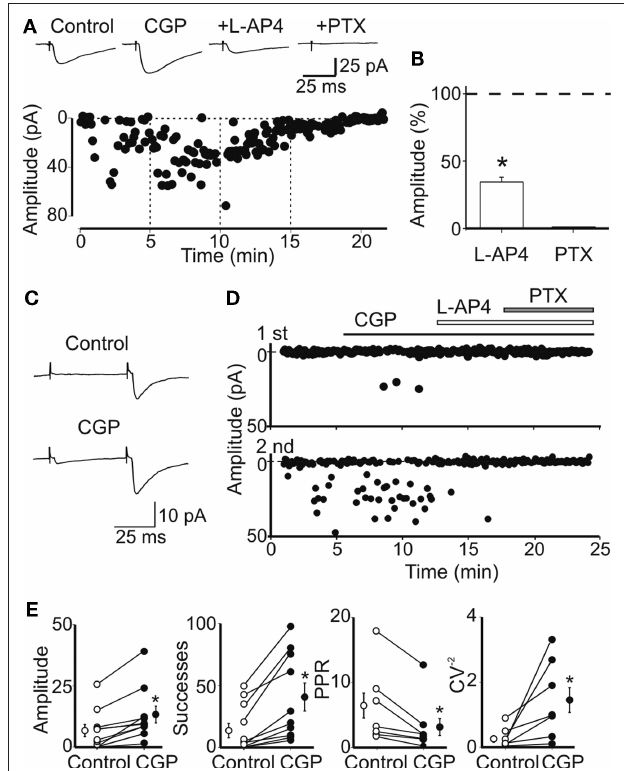
FIGURE 2 | Block of GABA receptors with CGP55845 enhances the B probability of GABA release from mossy fi ber terminals. (A) Peak amplitude of MF-evoked synaptic currents in control, during bath application of CGP55845 (1 μ M), CGP plus L-AP4 (10 μ M) and CGP plus L-AP4 and picrotoxin (100 μ M, vertical dashed lines). Note the reduction in the number of failures in CGP. Current responses were reduced in amplitude by L-AP4 and were blocked by picrotoxin. Insets above the graph represent averaged traces (20 individual samples including failures). (B) Each column in the graph represents the mean amplitude of synaptic currents (expressed as percentage of controls) evoked during bath application of L-AP4 and picrotoxin (* p < 0.05). (C) A presynaptically silent neuron before (upper trace) and during bath application of CGP55845 (1 μ M, lower trace). Note the appearance of a synaptic current in CGP (each trace is the average of 20 individual samples). (D) Peak amplitude of MF-evoked synaptic currents for the cell shown in (C) before and during bath application of CGP, L-AP4 and PTX (closed and open bars). The upper graph refers to the fi rst response, the lower graph to the second one. (E) Summary plots of mean amplitude, success rate, paired- pulse ratio and inverse squared of CV in control (open circles) and during bath application of CGP (closed circles). In this and in the following fi gures, on the left and on the right of individual responses are represented averaged values; * p < 0.05. Amplitude and successes refer to three silent and seven non-silent neurons. PPR and CV − 2 refer only to non-silent